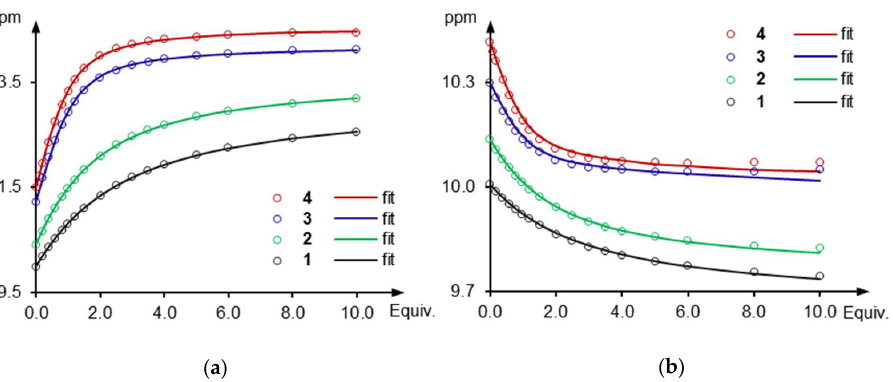
Figure 2. 1 H NMR titration curves of the ( a ) NH carb. and ( b ) NH amide signals of receptors 1 – 4 (10 mM) for TBACl in DMSO-d 6 + 0.5% H 2 O at 298 K. The 1:1 modeled fits are shown as solid